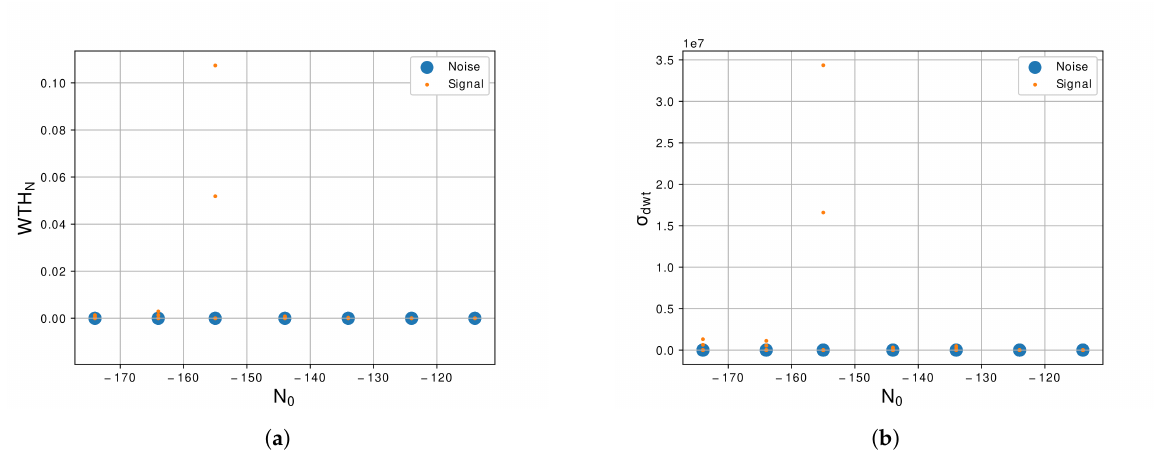
Figure 8. Graphic of the features ( a ) WTH N , Equation (11), and ( b ) σ dwt , Equation (12), with the variation of N 0 of − 114 dBm/Hz to − 174 dBm/Hz.